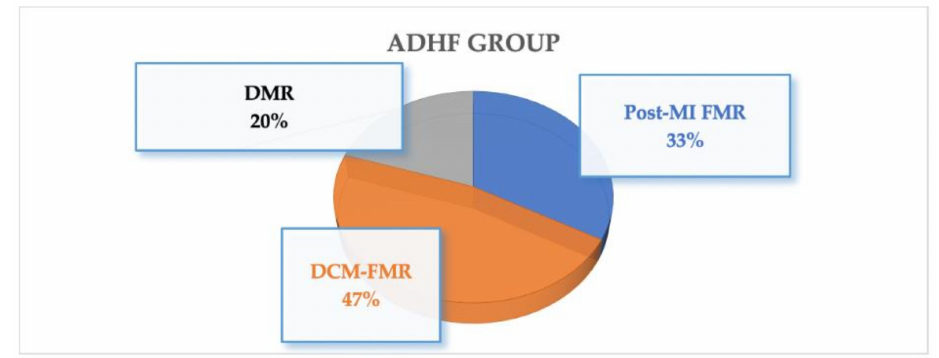
Figure 1. Etiology of MR in patients admitted due to ADHF. MR = mitral regurgitation; ADHF = acute decompensated heart failure; MI = myocardial infarction; DMR = degenerative mitral regurgitation; FMR = functional mitral regurgitation; DCM = dilated